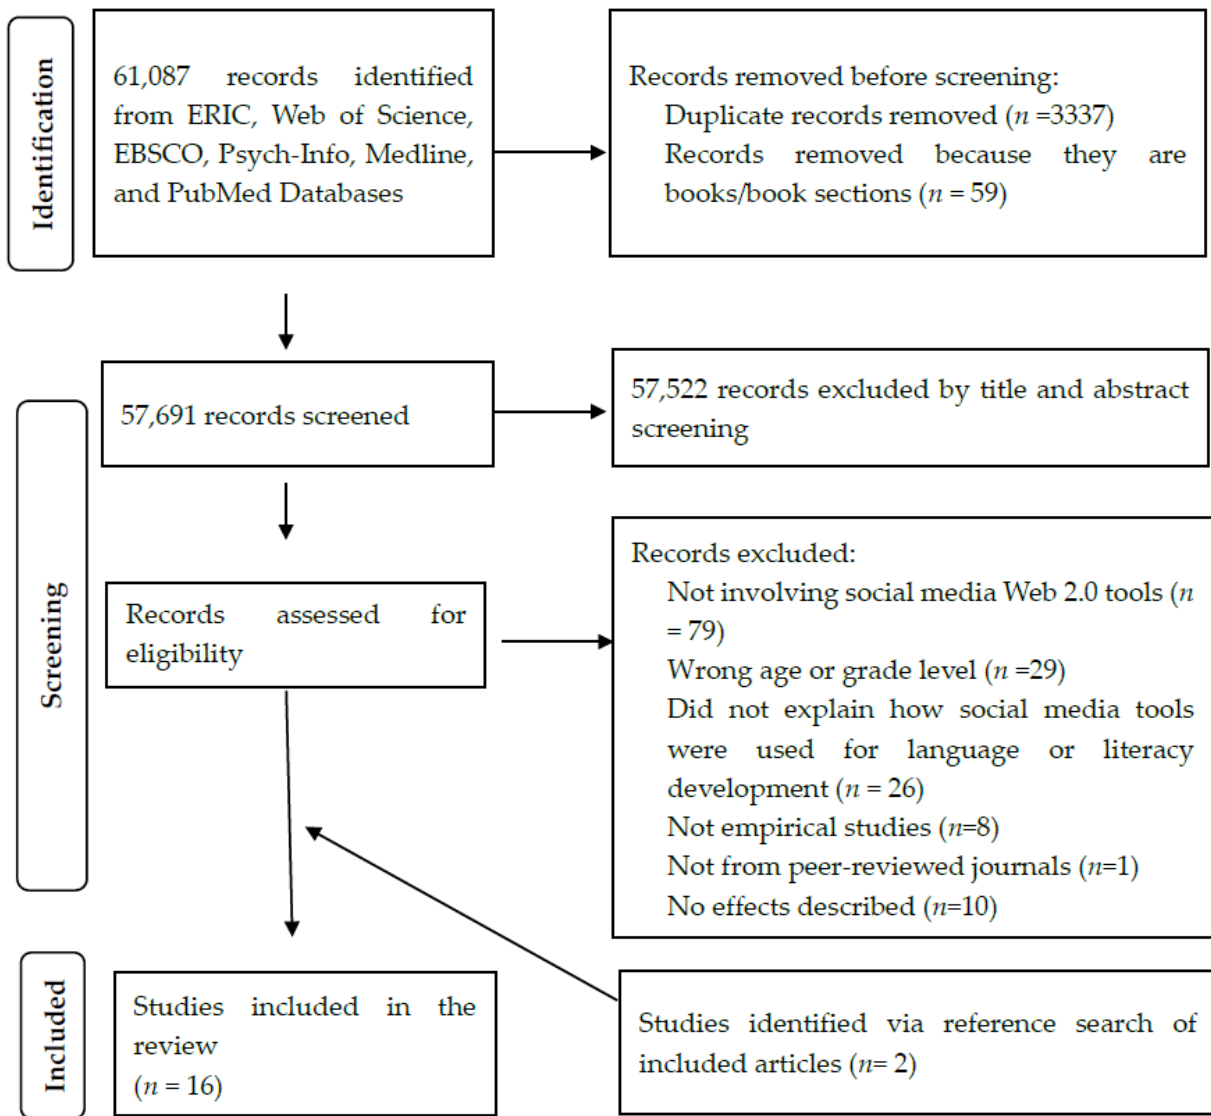
Figure 1. PRISMA diagram of included articles in the scoping review.